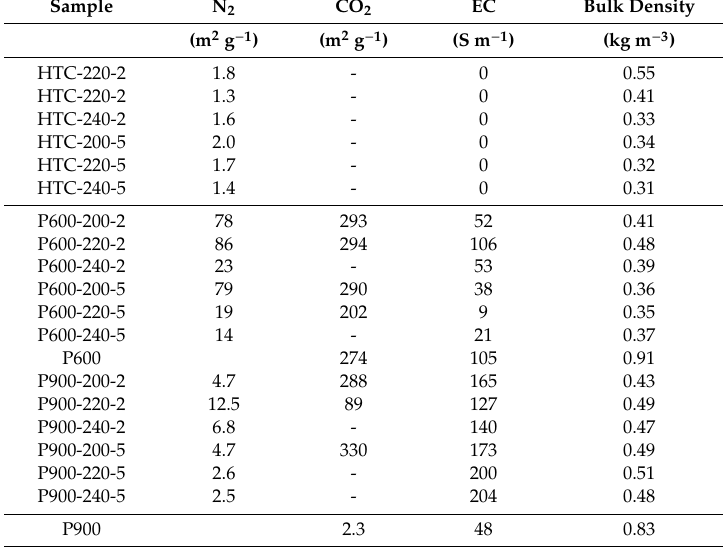
Table 2. Results of the specific surfaces measured with nitrogen and carbon dioxide and the electrical conductivity and bulk density. Sample N